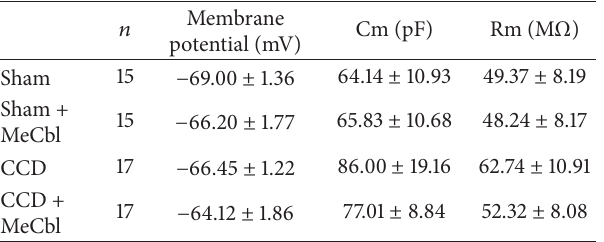
Table 1: The effect of MeCbl (10 𝜇 M) on passive membrane properties of medium-sized DRG